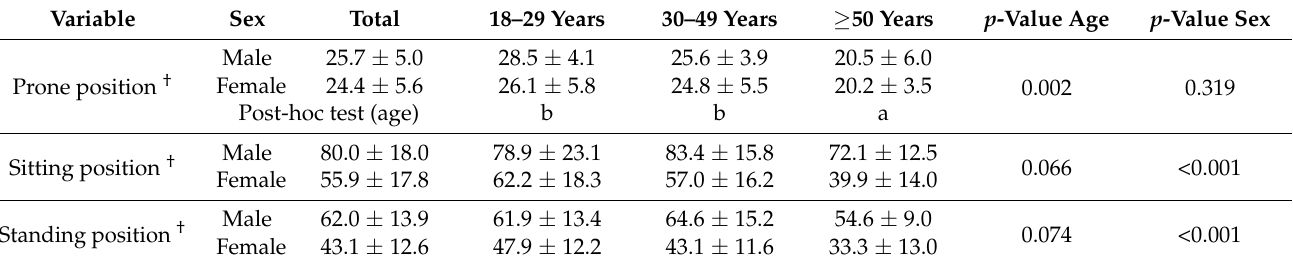
Table 2. Maximal isometric lower back extensor strength: results.